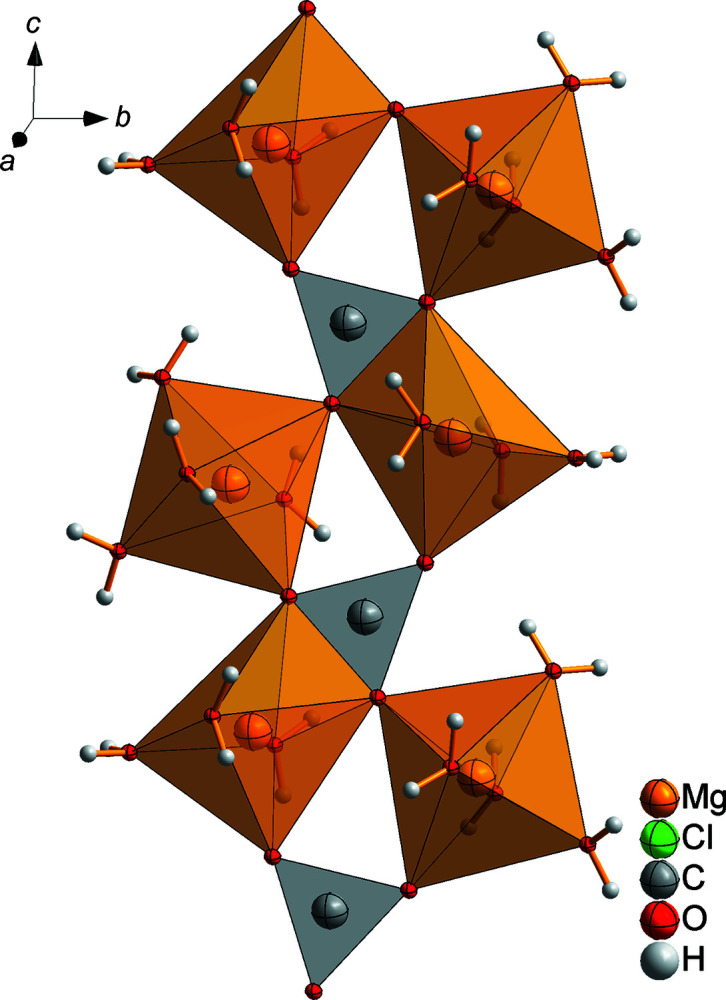
The characteristic structural motif in MgCO3·MgCl2·7H2O, showing the double chain of MgO octa­hedra linked by corners and carbonate units parallel to the (100) plane.